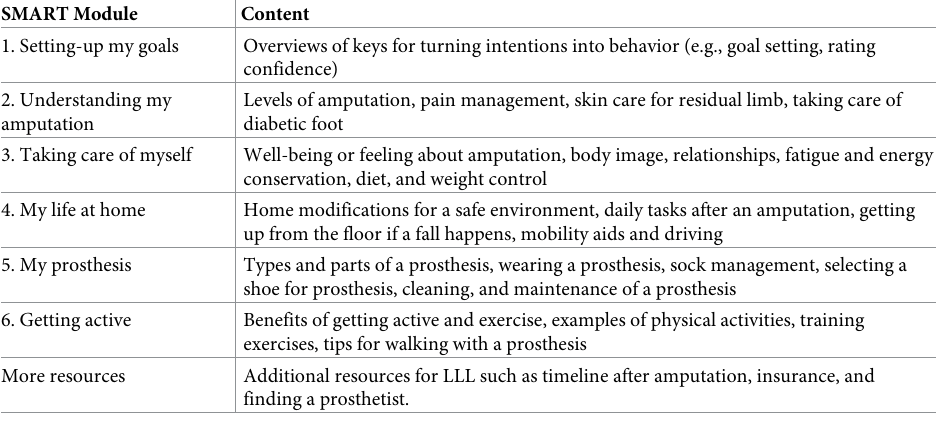
Table 1. Overview of Self-Management for Amputee Rehabilitation using Technology (SMART)